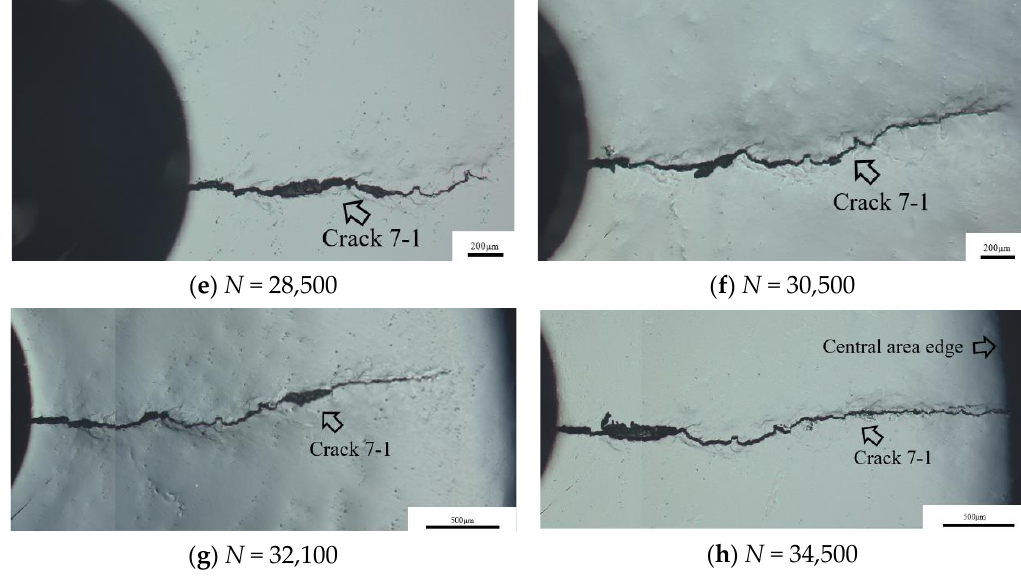
Figure 12. Crack 7-1 initiation and propagation process.